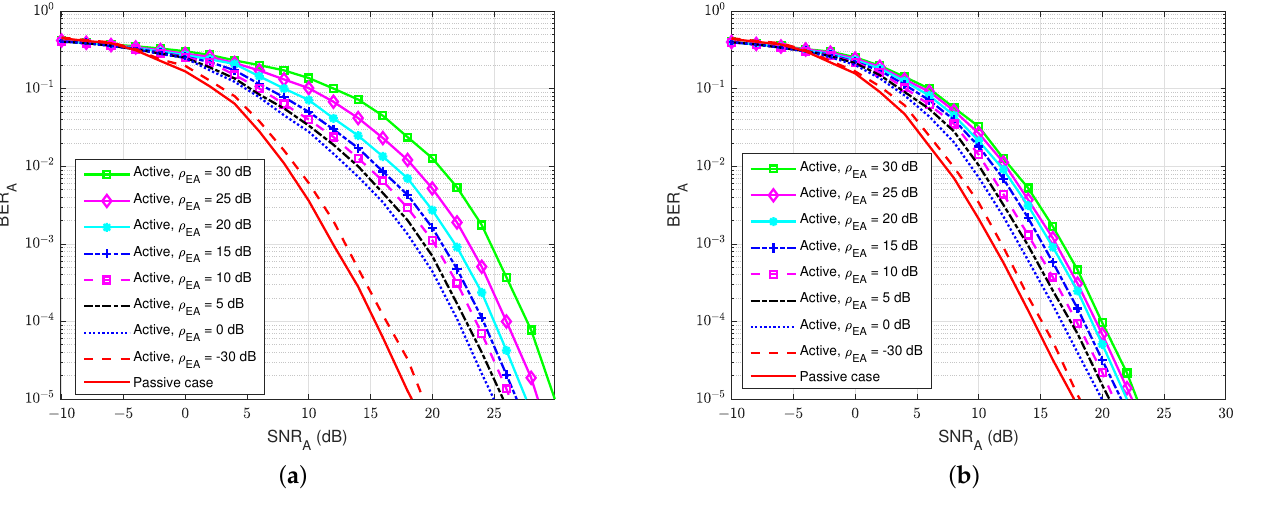
Figure 19. BER A versus SNR A , ρ AA = 30 dB in case of an active eavesdropper: ( a ) Blind feedback; ( b ) Semi-blind